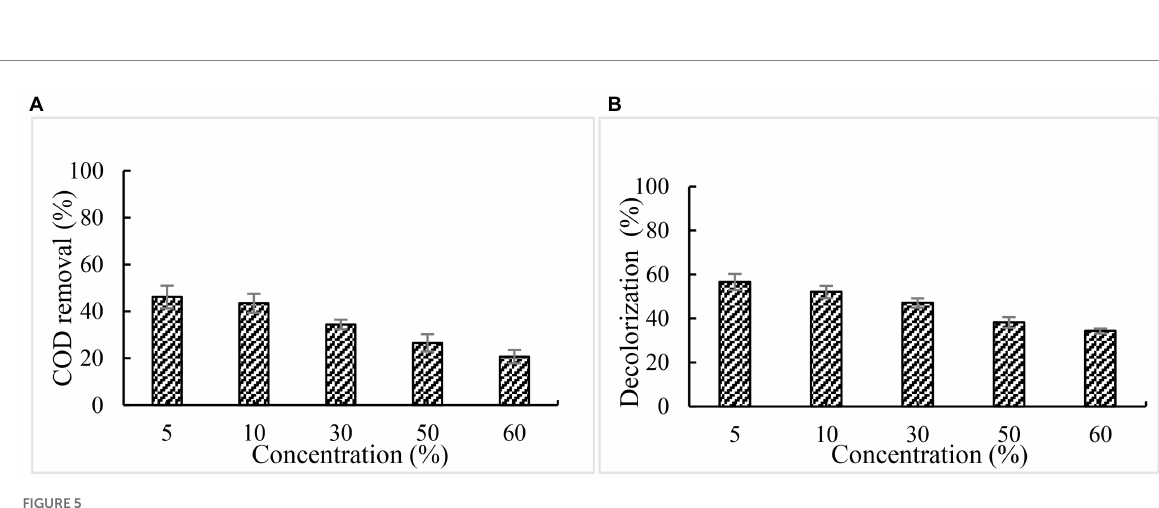
FIGURE 5 Effect of effluent concentration on COD and color removal. (A) COD; (B)